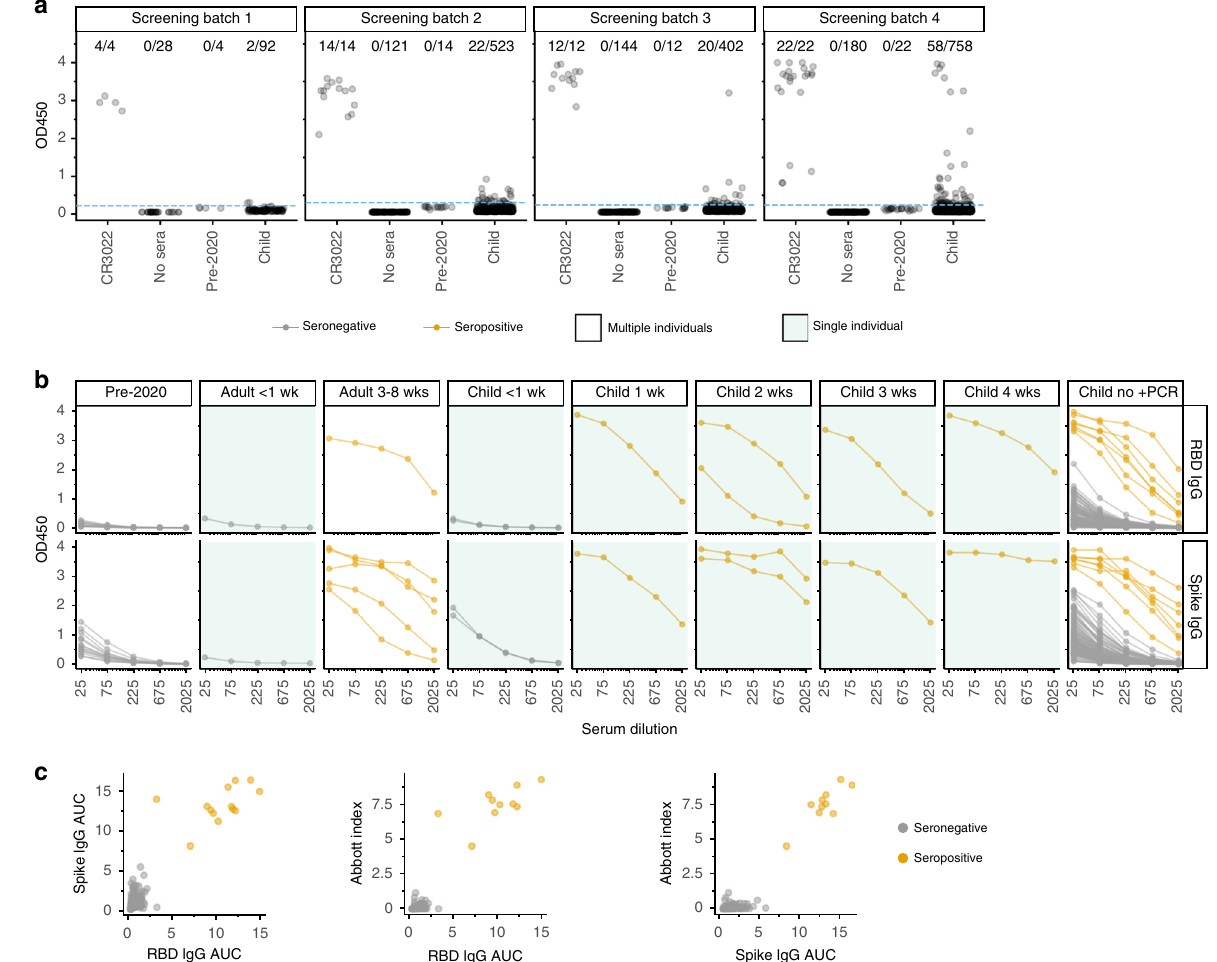
Fig. 1 Multistep serological testing. a We screened 1775 child samples by ELISA to RBD at a single dilution in four batches, with CR3022 antibody 18,19 as a positive control and pre-2020 sera as a negative control. Samples with OD450 readings that exceeded pre-2020 sera by >5 standard deviations (dotted blue line) were considered potential hits. b All potential hits from the initial screen, as well as some screen-negative samples and additional controls, were tested at serial dilutions for binding to RBD (top) or full spike (bottom). Samples from adults or children with RT-PCR-con fi rmed infections are labeled by weeks post symptom onset; all the remaining samples from children with no positive RT-PCR test are in the rightmost facet. Samples were classi fi ed as seropositive (orange) if the AUC exceeded pre-2020 negative controls by >5 standard deviations in both ELISA assays, and they were positive in the Abbott CMIA. All samples in green-shaded panels were from the same individual, whereas unshaded panels show samples from multiple individuals; see “ Methods ” for more details. c Correlation between RBD AUC, spike AUC, and Abbott index values (Pearson ’ s r = 0.93, 0.95, and